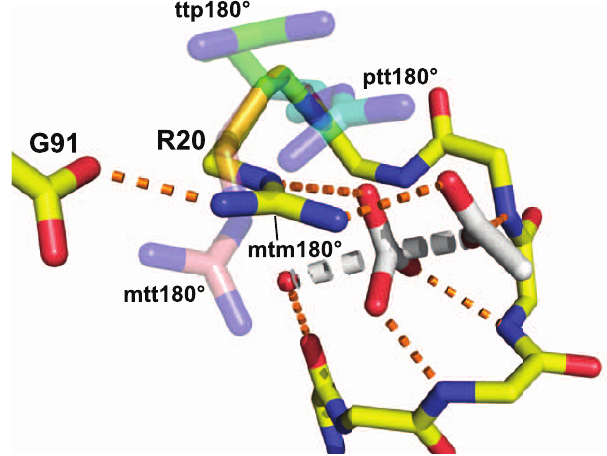
Figure 4. The active-site salt-bridge restricts the side-chain conformational freedom of the active-site arginine residue. The local flexibility of the active-site arginine residue (Arg-20 in PhWT and PhG91A or Arg-23 in HuG99 and HuA99) was examined by MD simulations. For acylphosphatases with the salt-bridge (PhWT and HuG99), the x 1, x 2, x 3, and x 4 dihedral angles of the arginine residue were confined to the values of , 300 u , , 180 u , , 300 u , and , 180 u , respectively. In other words, the side-chain of the arginine residue populates mainly in the mtm180 u rotamer. According to the convention of Lovell et al. [18], ‘‘p,’’ ‘‘t,’’ and ‘‘m’’ refers to dihedral angles of 60 u , 180 u , and 300 u , respectively. For acylphosphatases without the salt- bridge (PhG91A and HuA99), transitions from the mtm180 u to other rotamer conformations (ptt180 u , ttp180 u , and mtt180 u ) were evident. doi:10.1371/journal.pbio.1001027.g004 PLoS Biology |